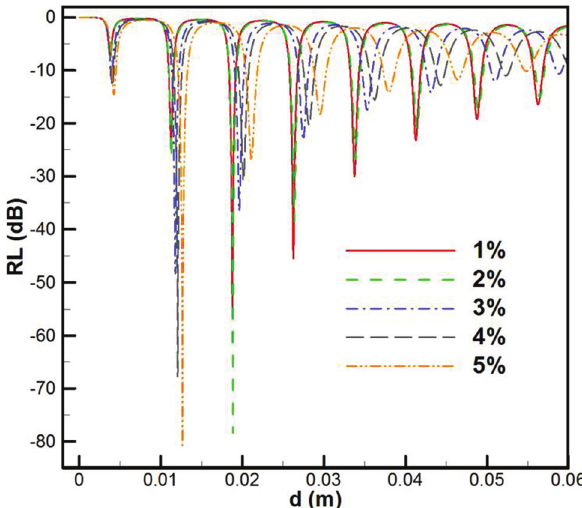
Fig. 2: Moist dependence of RL of petroleum coke as the thickness varies from 0 to 0.06 m at 20 °C: 1%, 2%, 3%, 4%, and